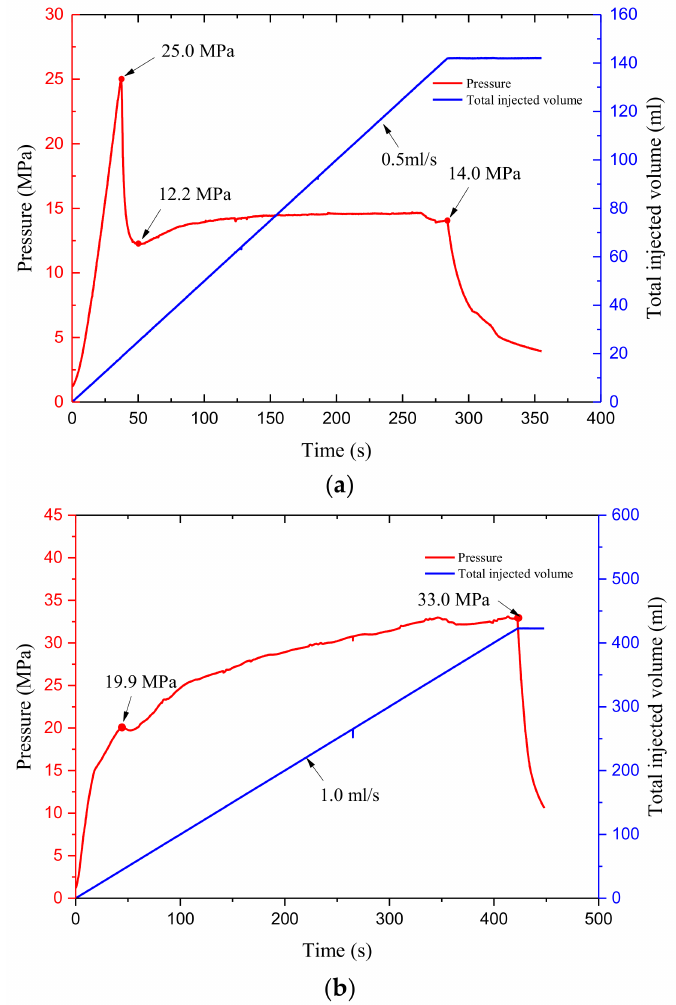
Figure 23. Variation of pump pressure and total injected volume during the test. ( a ) Sample Y-7-1; ( b ) Sample